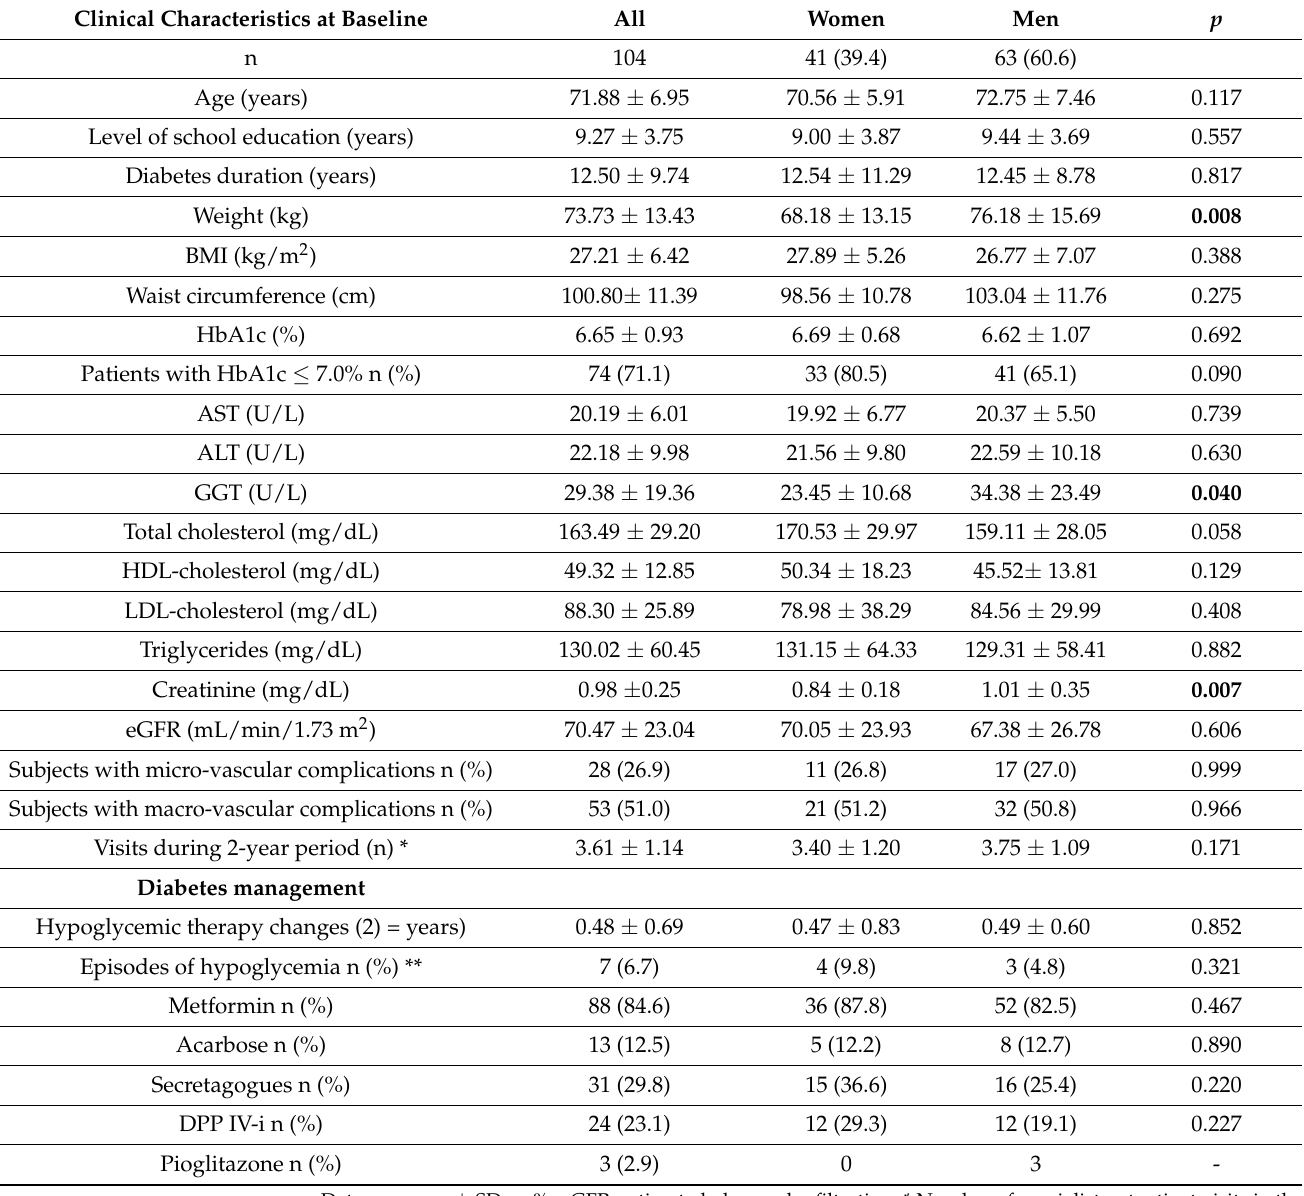
Table 1. Clinical characteristics at baseline of T2D elderly subjects participating in the study, according to